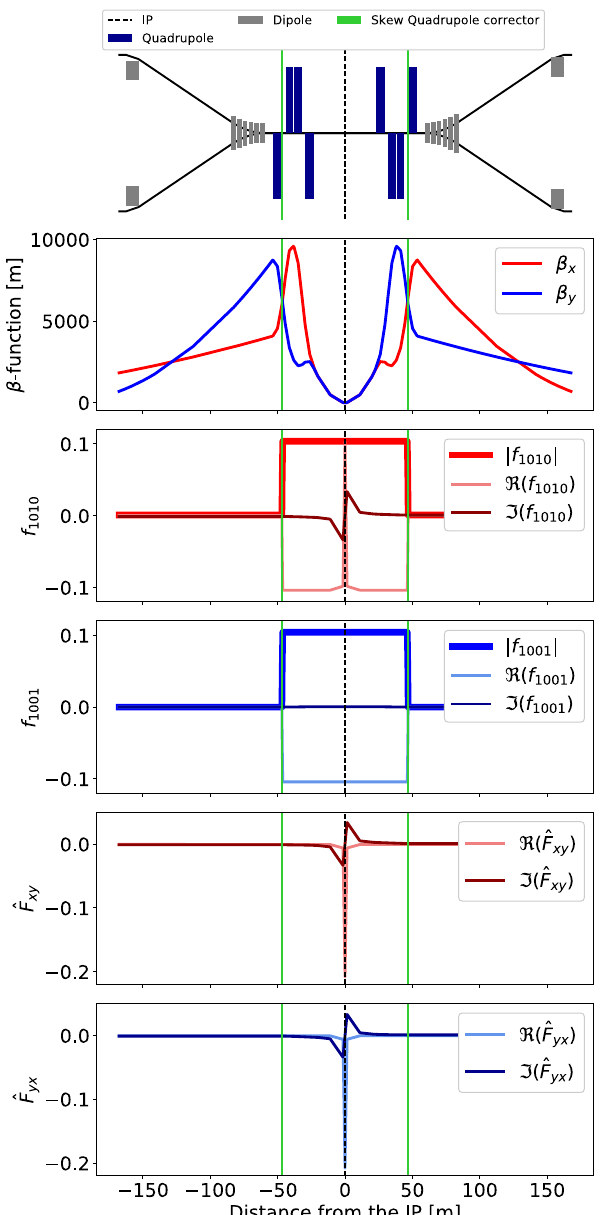
FIG. 1. Illustration of a LHC interaction region. The optics presented here corresponds to β (cid:5) ¼ 25 cm and the strength of the skew quadrupole correctors (shown in green) was set to K S L ¼ 6 . 7 × 10 − 5 m − 2 2